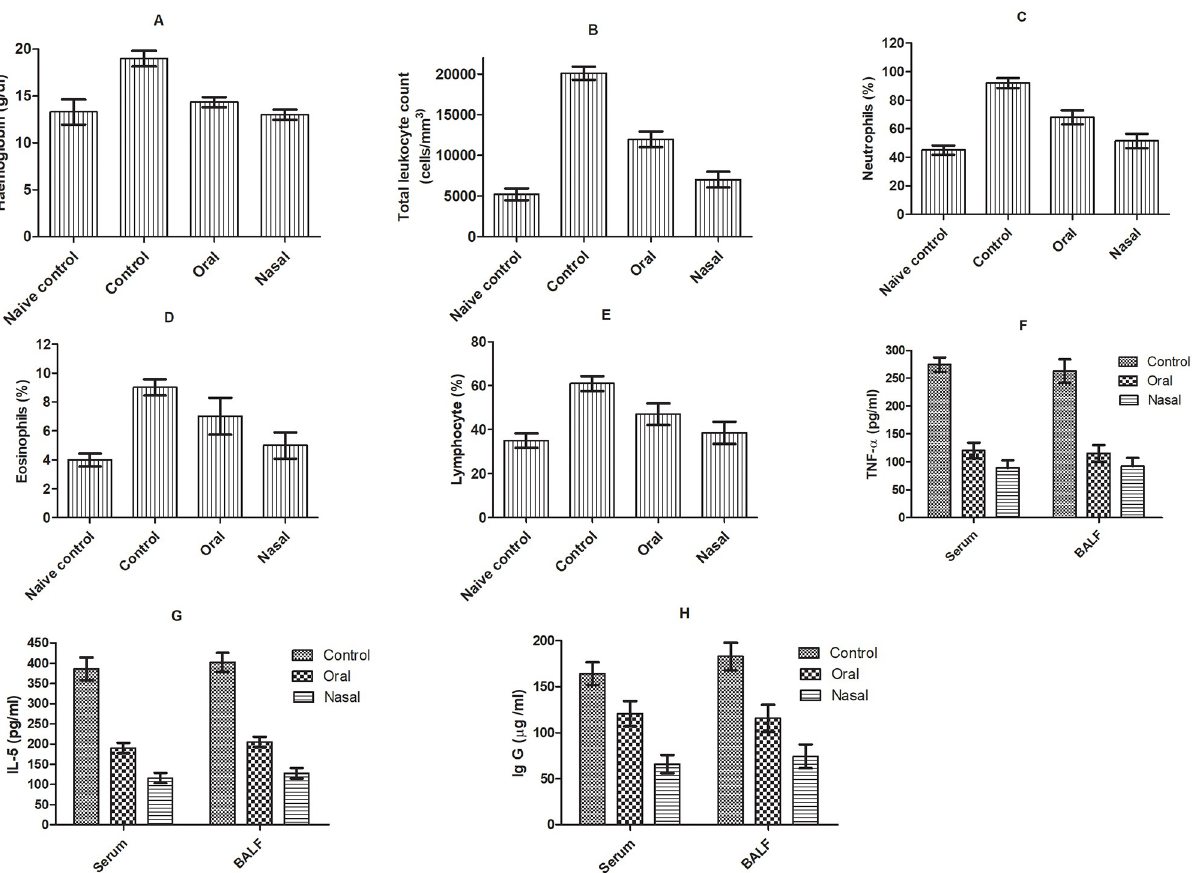
Fig 6. Effect of oral and nasal bromelain treatment on hematological and immunological biomarkers (A) hemoglobin, (B) total leukocyte count, (C) neutrophils, (D) eosinophils, (E) lymphocyte, (F) TNF– α , (G) IL-5, (H) Ig-G respectively in OVA induced asthma model.